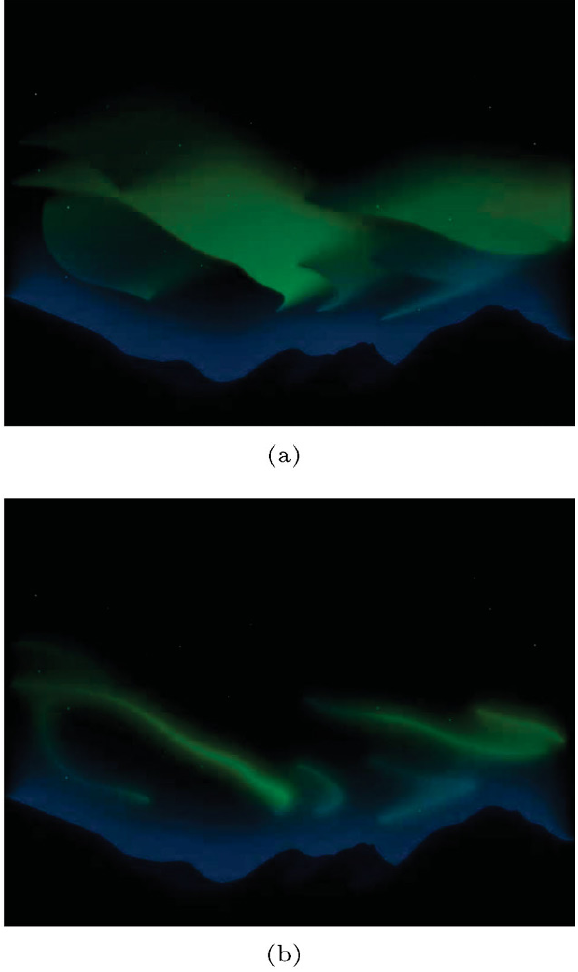
Fig. 2 With suitably designed values, the coefficient layer c ( x,y ) can be used to control the diffusion direction and strength. (a) Aurora image generated by the DCC model with direction coefficient